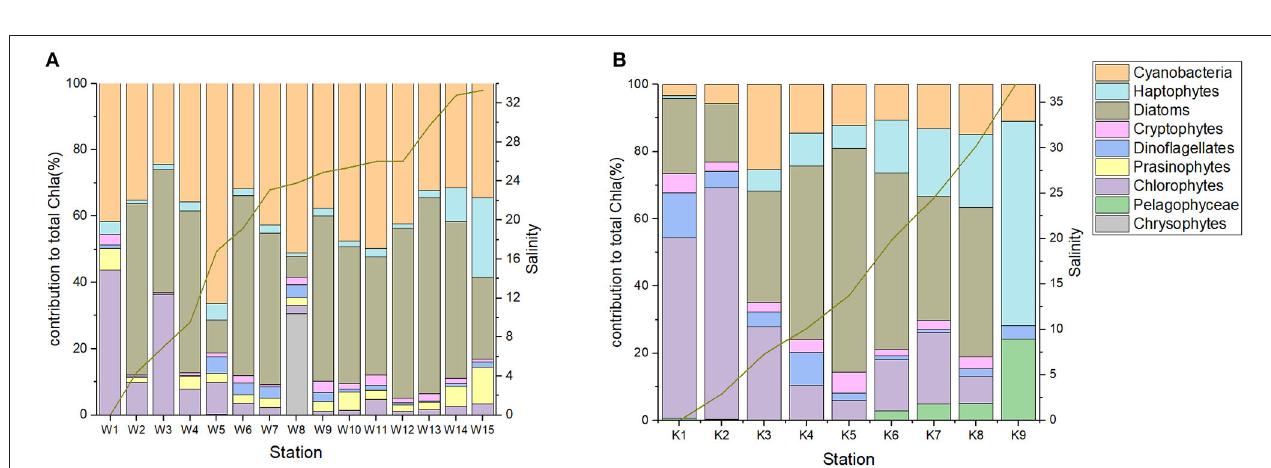
FIGURE 7 | Phytoplankton community succession vs. salinity in surface waters in (A) the WRE and (B) KRE as estimated by CHEMTAX based on HPLC measured pigments. The lines indicate the salinity. The raw pigment data are from Vrana Špoljari ´ c et al. (2021).